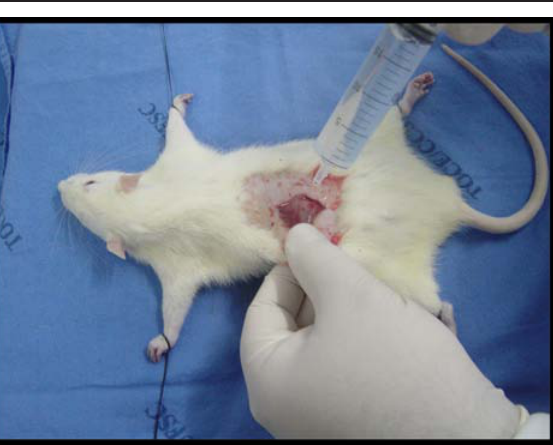
FIGURE 2 - Picture showing wound being contaminated with 1ml of inoculum .